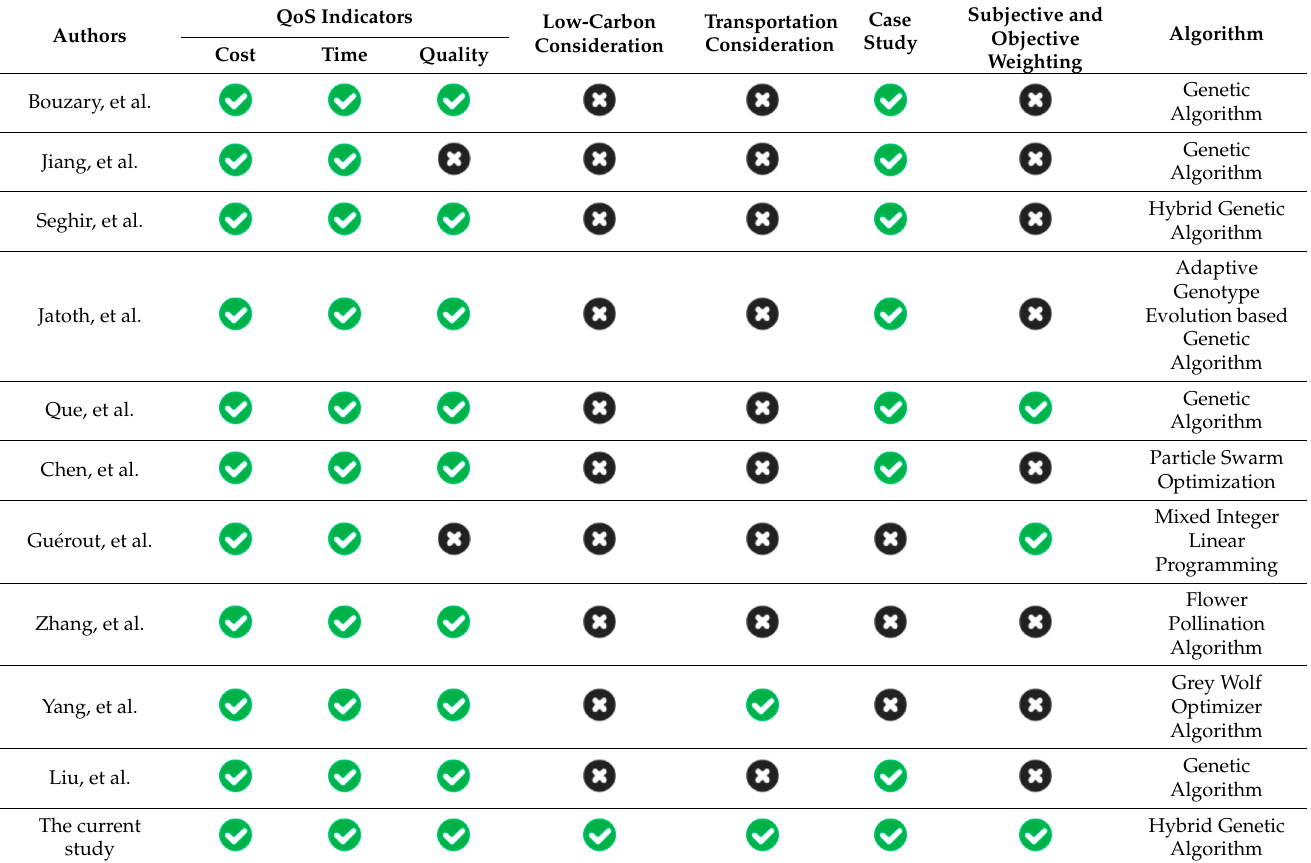
Table 1. A chronological literature review on the SCOS problem at a glance.